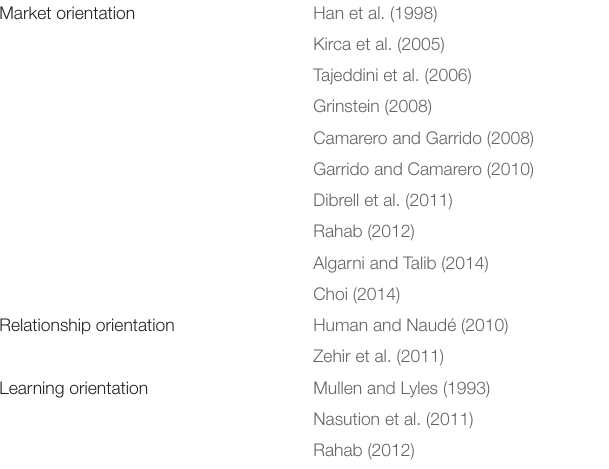
TABLE 2 | Main antecedents of innovation